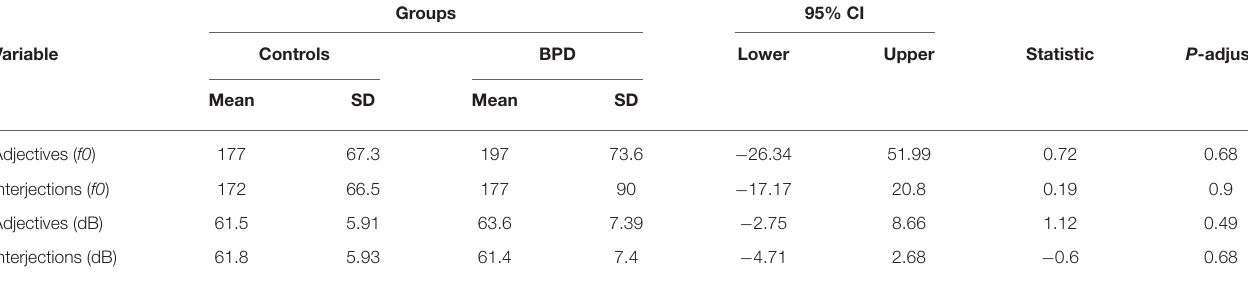
TABLE 2 | Acoustic parameters of voice